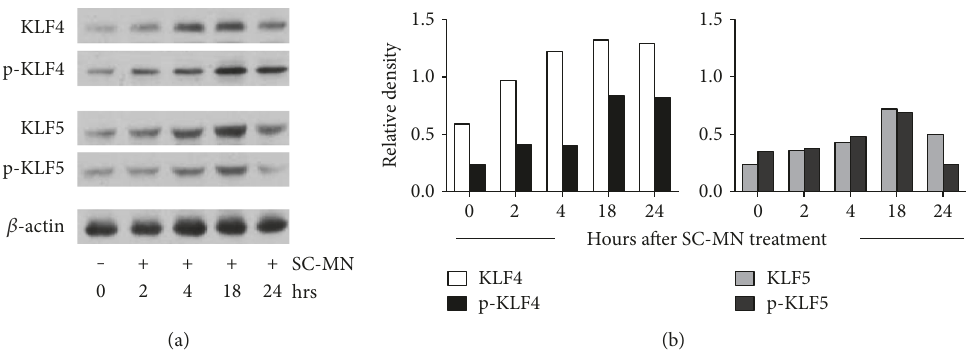
Figure 6: Expression and activation of KLF4 and KLF5 by SC-MN in NHBEC. (a) Phosphorylated forms indicate protein activation. (b) Density of each protein relative to β -actin. Data are representative of two independent